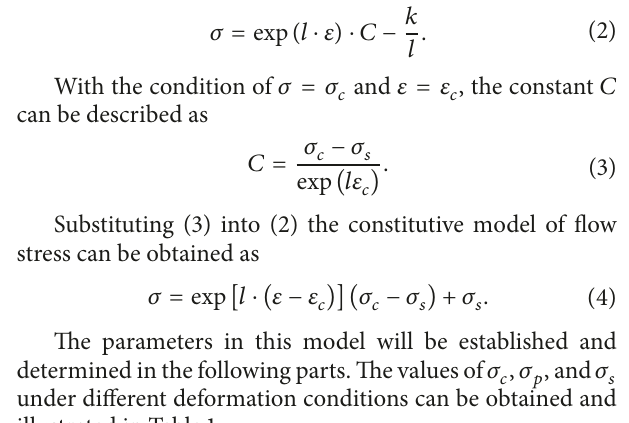
on a Gleeble-3500 thermomechanical simulator. Cylindrical specimens were machined with 8 mm in diameter and 12 mm in